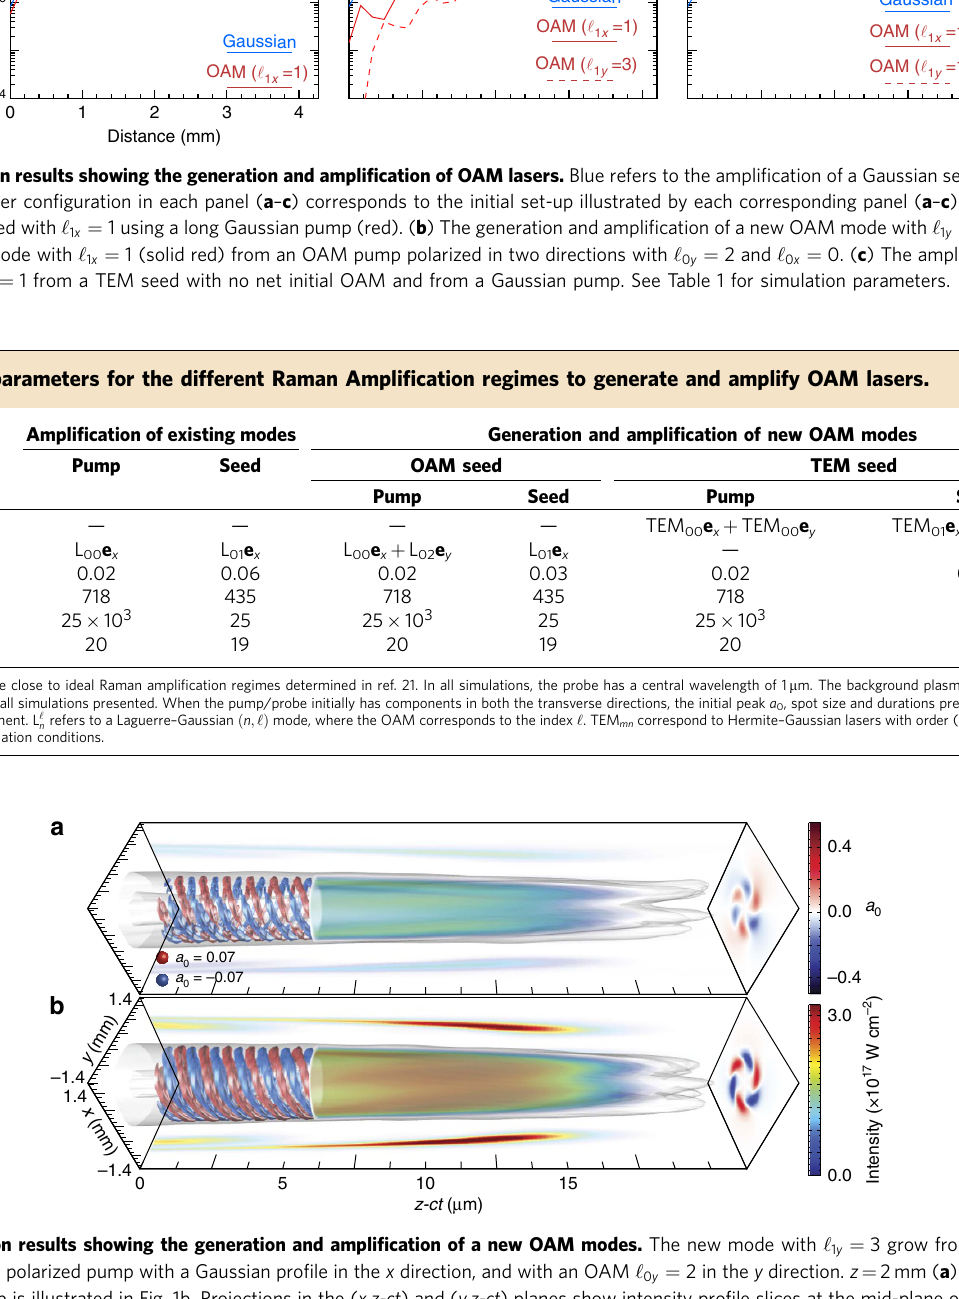
absent from the simulation, from a pump with ‘ 0 y ¼ 2, ‘ 0 x ¼ 0